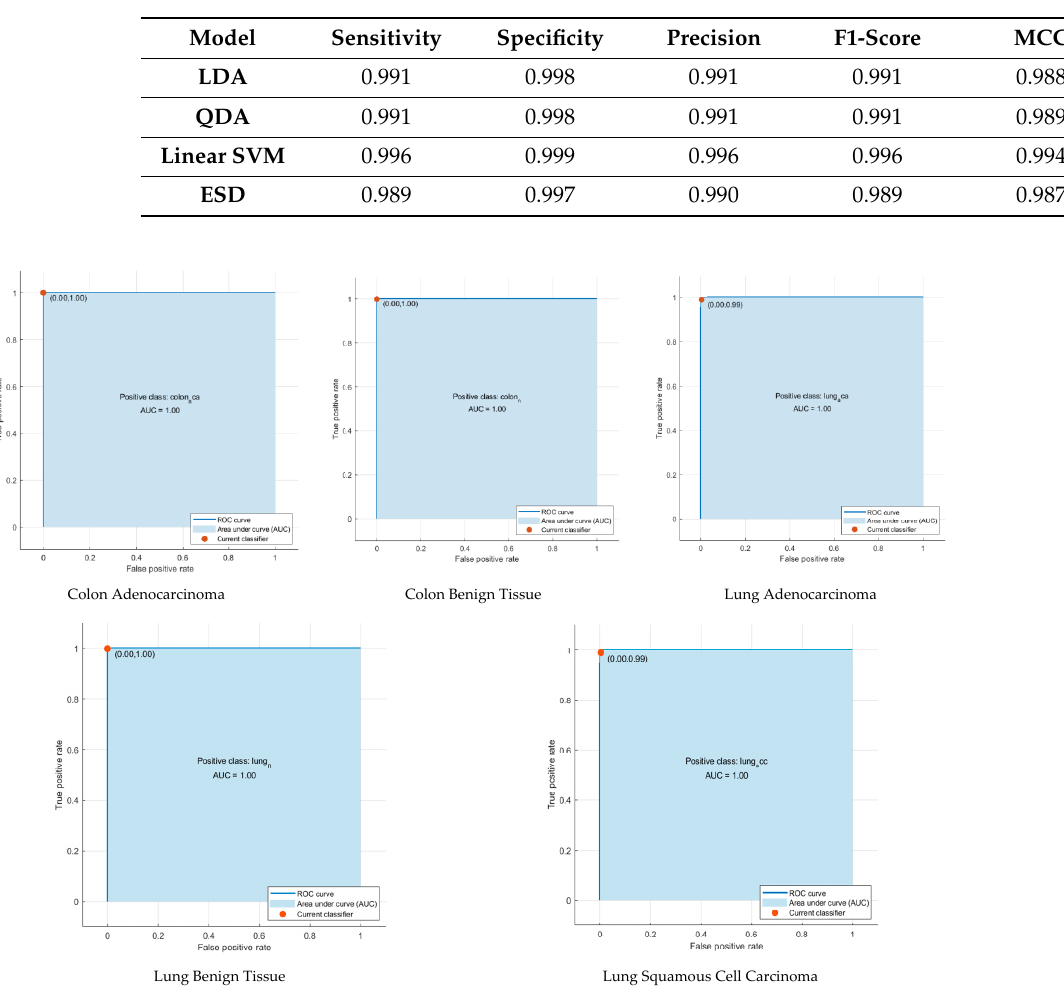
Figure 5. Confusion matrices obtained as a result of classification of PCA-based incorporated CNN features with machine learning algorithms. Table 2. Performance measures attained using the combined PCA coefficients of the three CNNs.